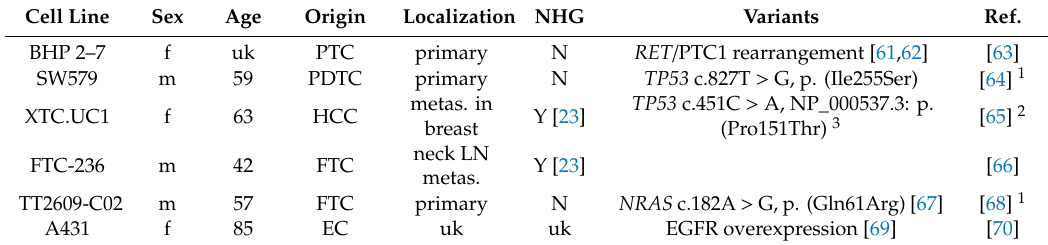
Table 1. Cancer cell line characteristics used for Western blot